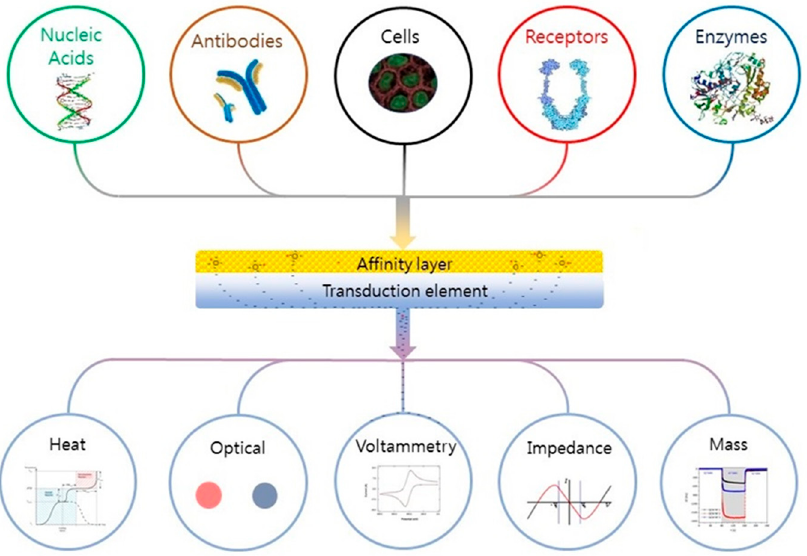
Figure 4. Schematic of a biosensor. Reading from the top down; A tailored affinity layer specific to an analyte or analytes. Binding of an analyte to the layer leads to changes in its physical properties (electrochemical, optical, heat, etc.), which are converted into a measurable signal by the transduction element; these are then relayed to and recorded by an electronic meter or visually (coloration) identified by the subject. Figure reproduced with permission from Elsevier [68].